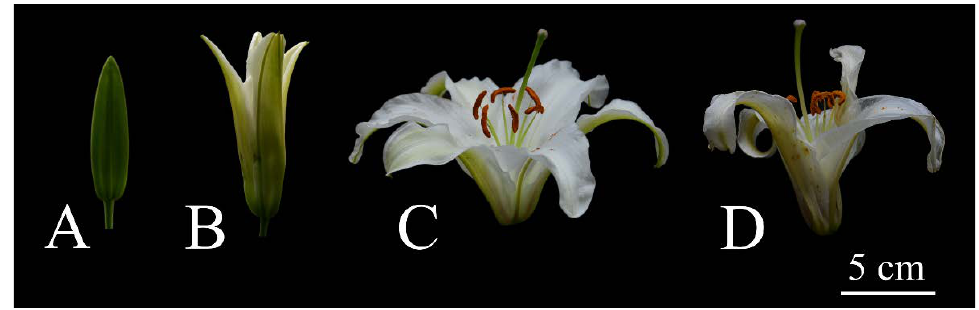
Figure 1. Flower opening stages in Lilium oriental ‘Siberia’. ( A ) Stage 1: flower bud grows to the largest size, color of tepals does not turn white; ( B ) stage 2: early opening, the upper one third of the tepals were opened with an angle of 30 degrees; ( C ) stage 3: full opening, the tepals extend to the maximum extent; ( D ) stage 4: flowers are senescent, the tepals are wilting. As for transient overexpression in lily tepals, cut flowers of lily ( L. oriental ‘Siberia’) were bought from Nanhu flower market and transported to the laboratory within one hour. The flower stems were cut to a length of 30 cm and the leaves at the stem base were removed; the flowers were then placed in vases with distilled water.